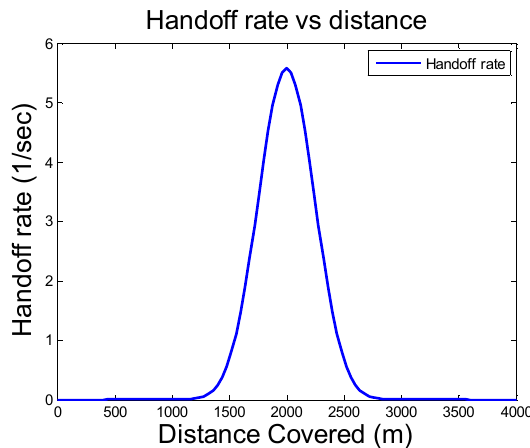
Figure 7. Theoretical and simulated average outage duration for a dual diversity scheme vs. distance covered.